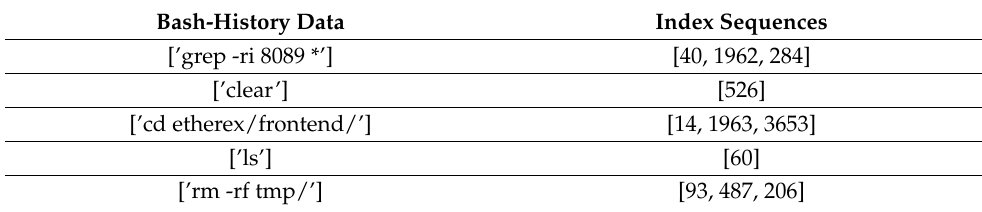
Table 8. Index sequence representation of